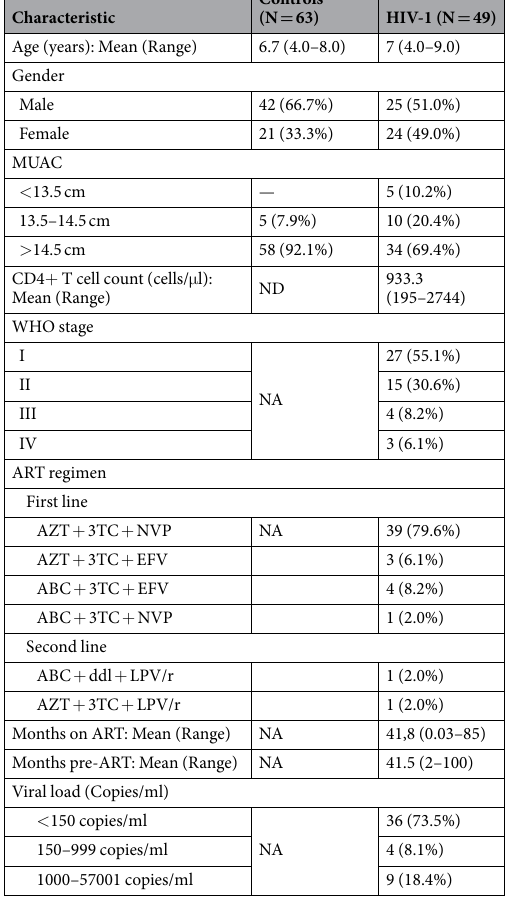
Table 2. Clinical characteristics of healthy controls and HIV-1 infected children included in the HBV vaccination study. ND = not done. NA = not applicable. MUAC = Mid-Upper Arm